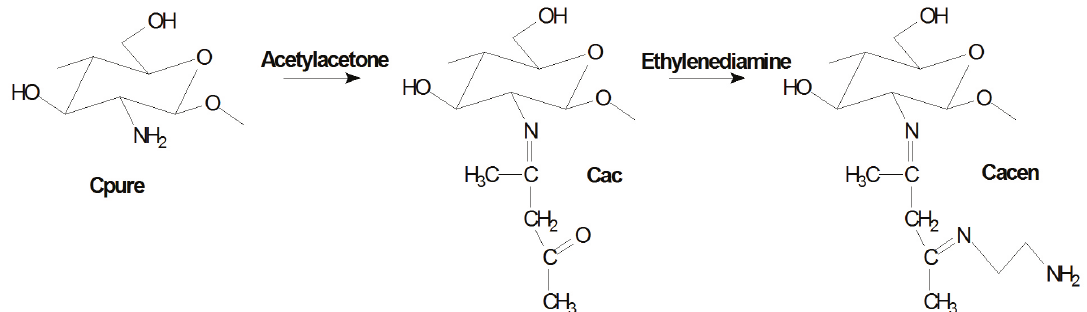
Figure 1. Proposed reaction scheme of the chemical modification of